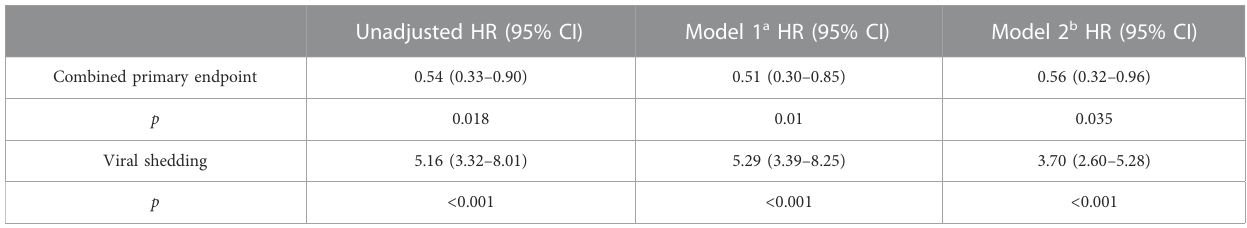
TABLE 3 Outcomes for patients with SARS-CoV-2 infection and impaired kidney function with and without Nirmatrelvir/ritonavir therapy.